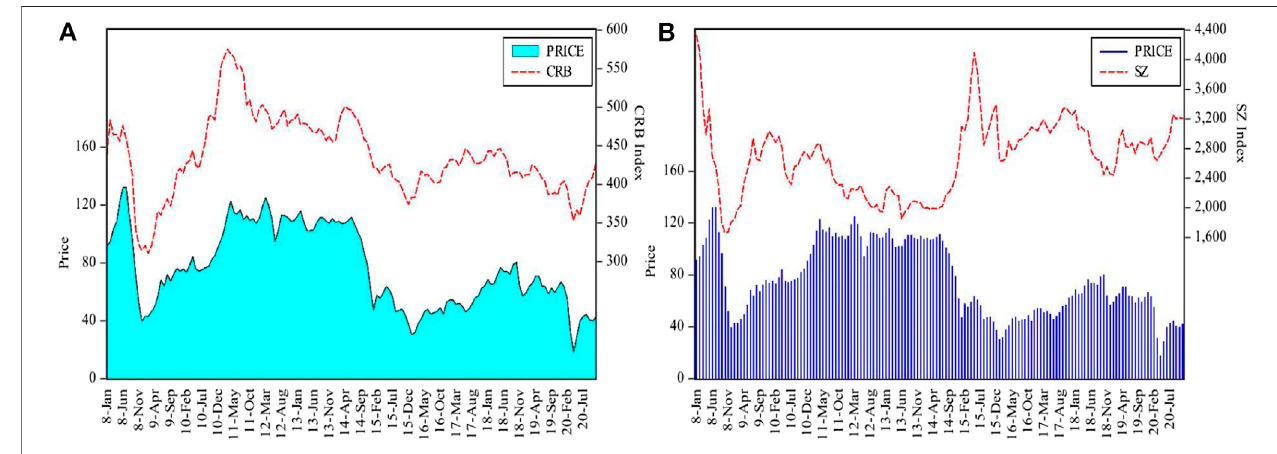
FIGURE 1 | Crude oil price and CRB index (A) and SZ index (B)